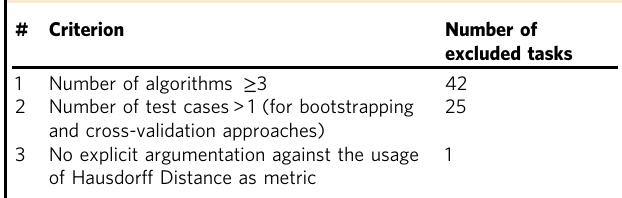
Table 3 Inclusion criteria on task